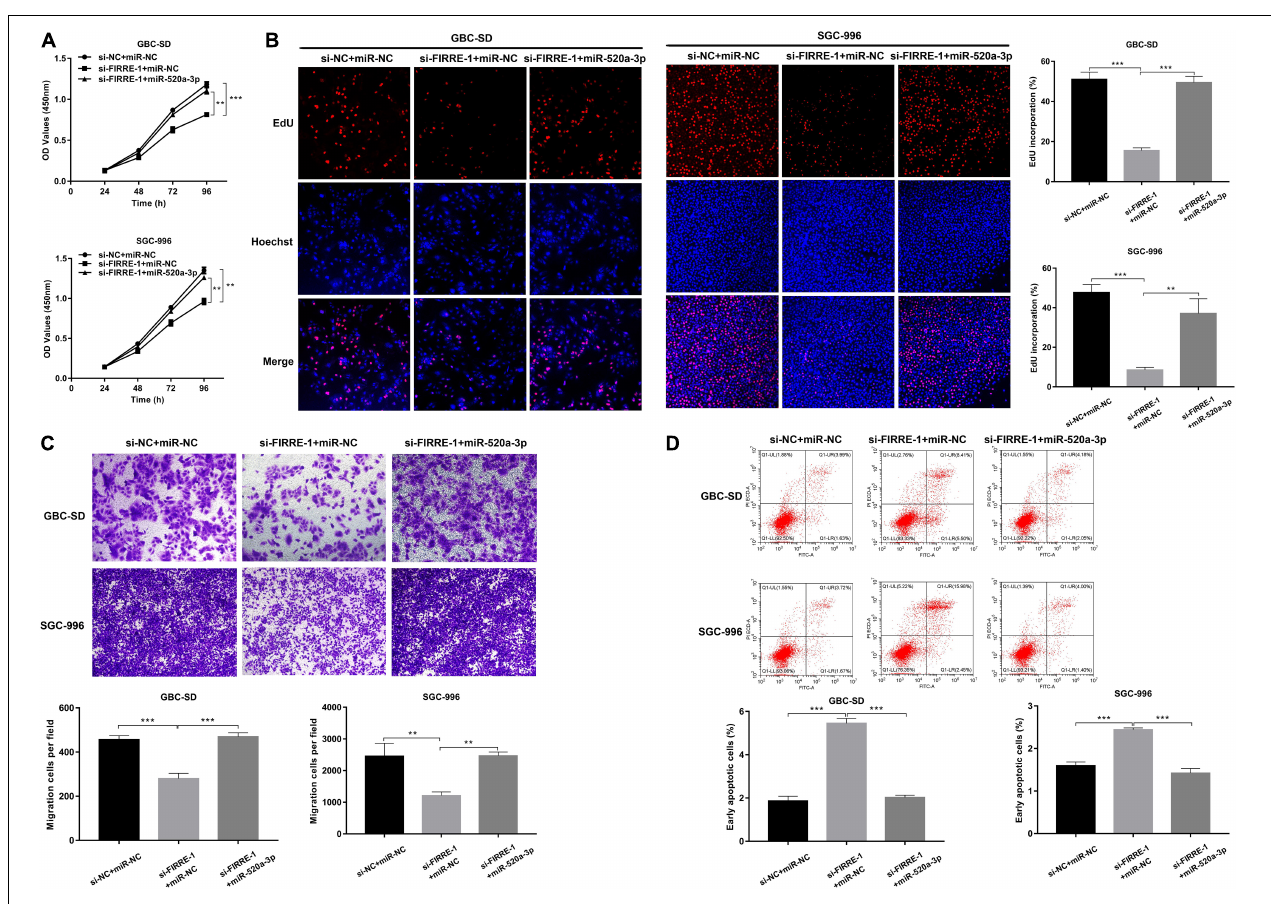
FIGURE 5 | The proliferation, migration, and apoptosis in GBC cells co-transfected with si-FIRRE-1 and miR-520a-3p mimics. (A) The proliferation ability of GBC-SD cells and SGC-996 cells co-transfected with si-FIRRE-1 and miR-520a-3p mimics determined by CCK-8 assays. (B) The cell proliferation was determined by EdU assays. (C) The migration ability was examined after transfection with si-FIRRE-1 and miR-520a-3p mimics by transwell assays. (D) The apoptosis of co-transfected GBC-SD cells and SGC-996 cells. ** p < 0.01, *** p <